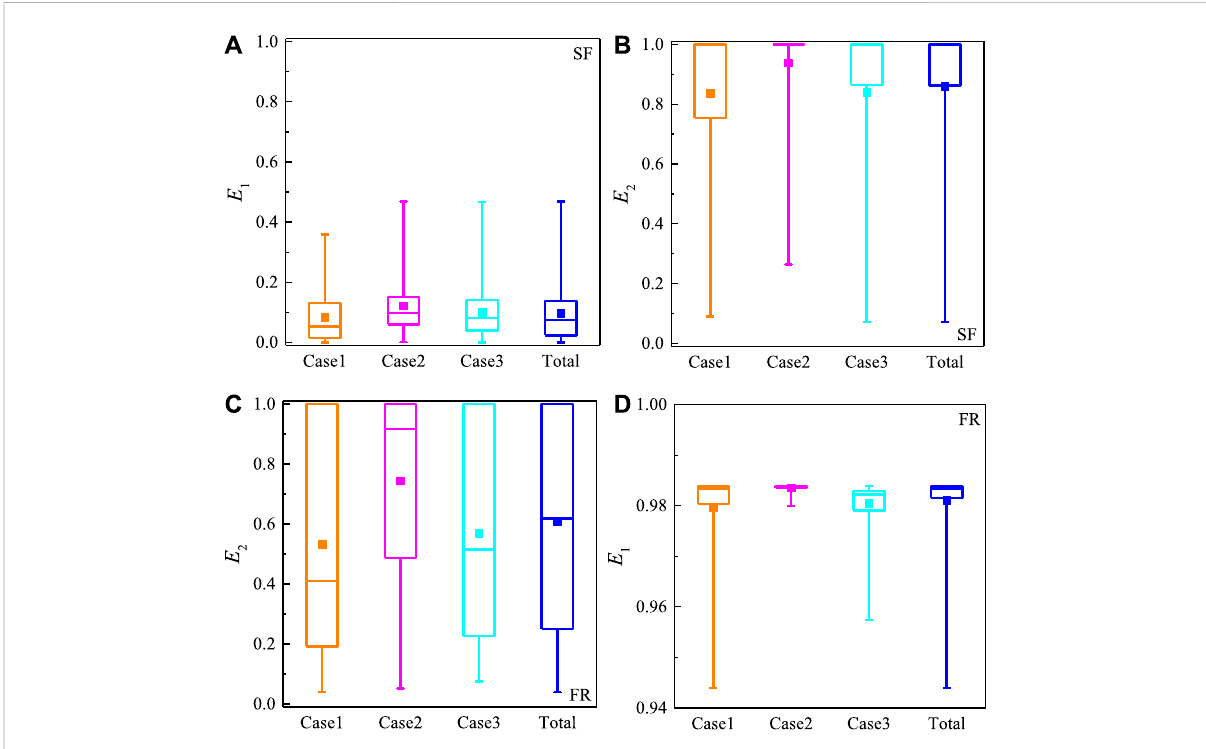
FIGURE 4 Distribution characteristics of collision rates (E1) of supercooled fog (A) and freezing rain (C) , and freezing rates (E2) of supercooled fog (B) and freezing rain (D) ofthe three iceaccretion cases inwinter of 2008 and 2009. The central box represents thevalues from thelower to upperquartiles (25th to 75th percentiles), and the vertical line extends from the minimum to the maximum. The middle solid square and line represents the mean value and median value,